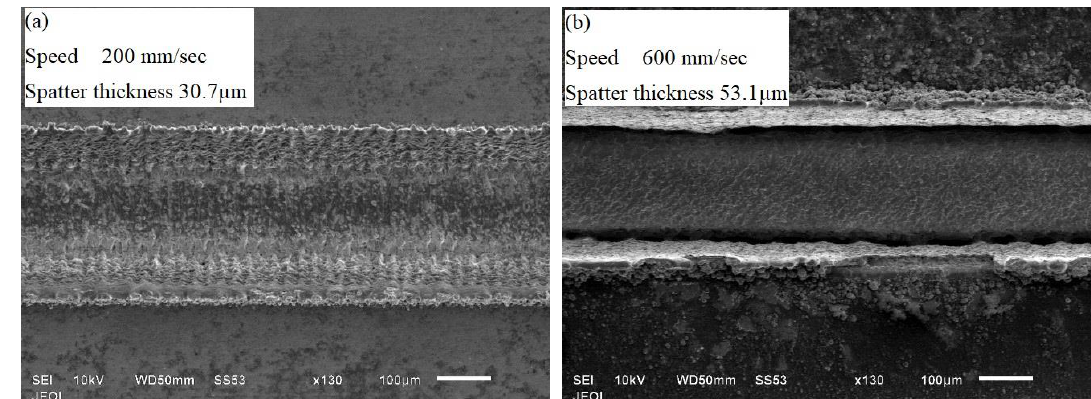
Figure 9. SEM images of the microchannel showing the variation of spatter with scanning speeds of ( a ) 200 mm/s and ( b ) 600 mm/s .